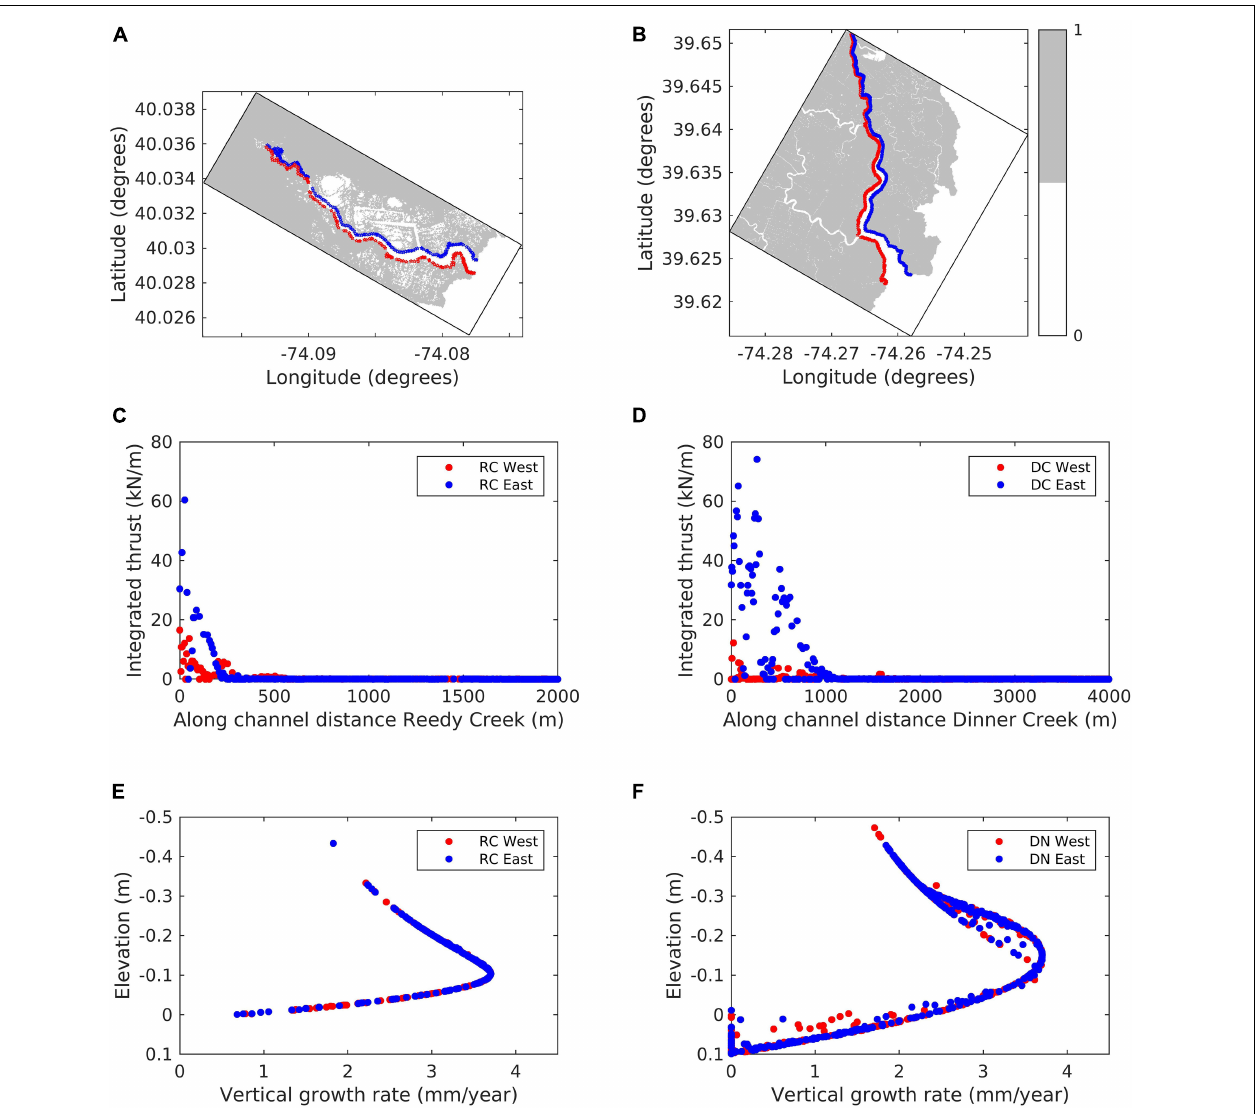
FIGURE 11 | Extraction of shoreline points along the tidal creek channel on the east (red) and west (blue) sides of the (A) Reedy Creek (RC) and (B) Dinner Creek (DC) domains with marsh shown [Marsh mask = 1 (gray contour) indicates marsh presence]. Graph show the along channel variation of integrated lateral wave thrust (LWT) for both the eastern and western sides of (C) RC and (D) DC domains; and vertical growth rate (VGR) variation with marsh elevation (negative elevation refers to points above MSL) for shoreline points located on the eastern and western sides of (E) RC and (F) DC domains at the end of the